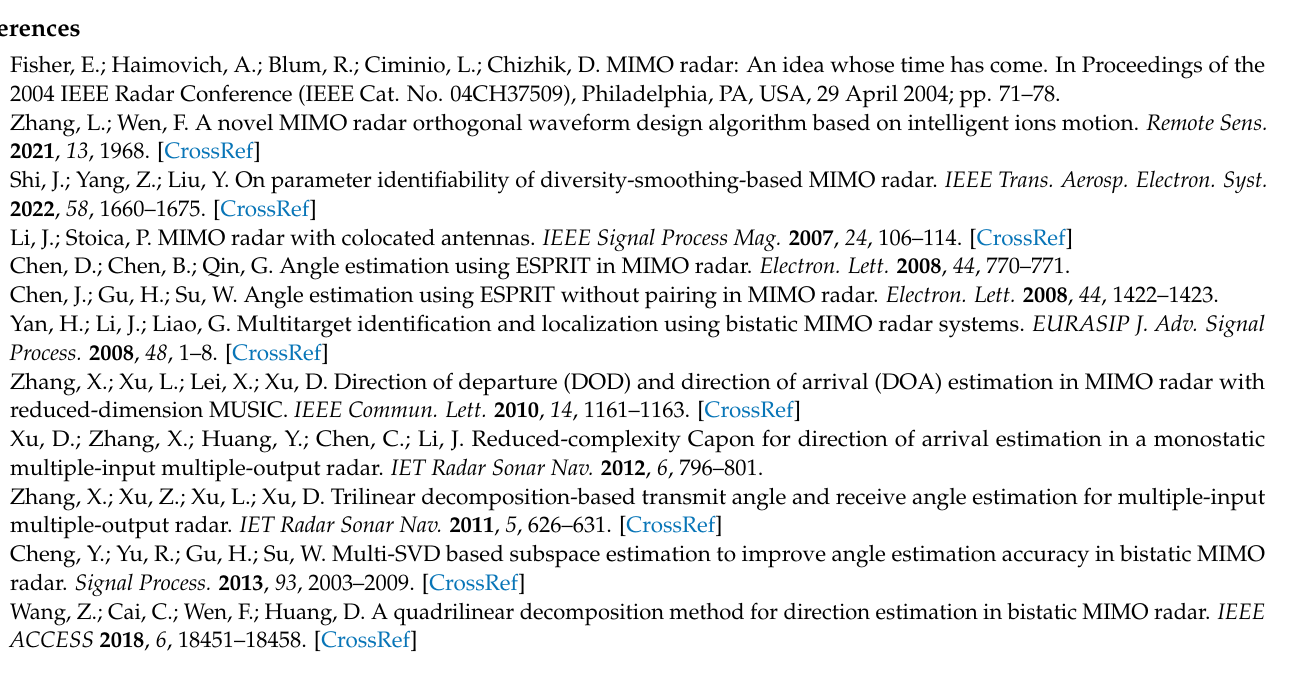
Figure 7. RMSE comparisons versus target distance